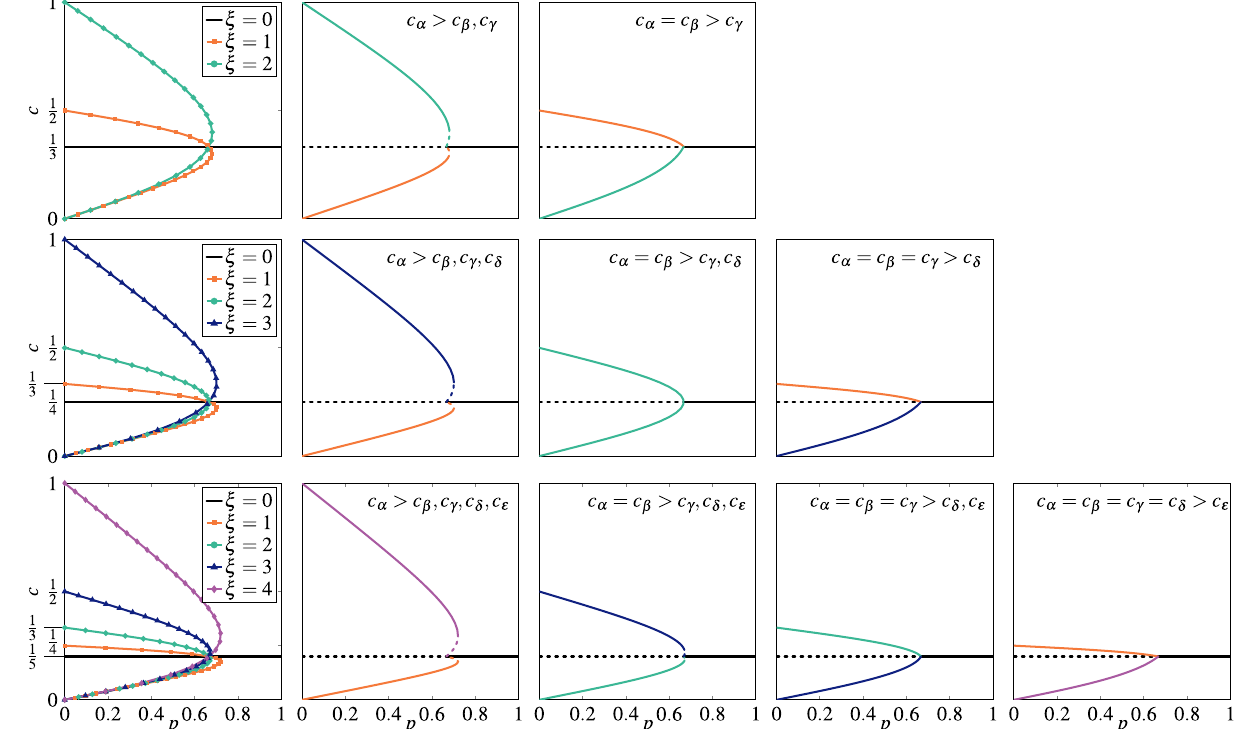
Figure 5. Steady states, given by the solution of Eq. (30), for the quenched model with q = 3 . The distribution of opinions is the same for Independent and Conformist agents. Each row corresponds to a different number of states: s = 3 (top panels), s = 4 (middle panels), s = 5 (bottom panels). The first column represents all possible solutions indexed with different values of ξ without the distinction between the stable and unstable solutions. The remaining columns represent stationary states for initial conditions indicated in the top right corner of each panel, where α , β , γ , δ , ǫ ∈ { 0, 1, . . . , s − 1 } . Stable solutions are denoted by the solid lines, whereas the unstable ones are marked with the dashed